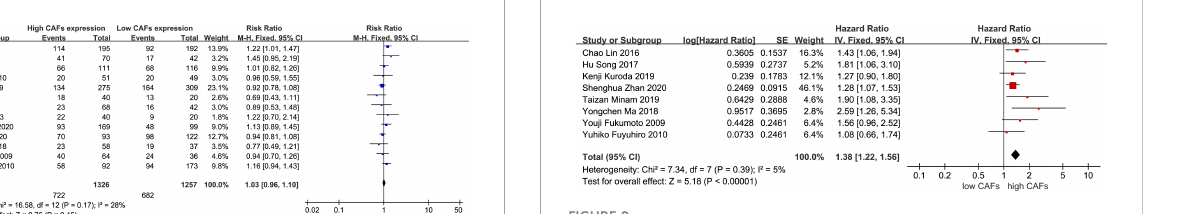
FIGURE 9 Association between CAFs and OS in gastric cancer. CAF, cancer-